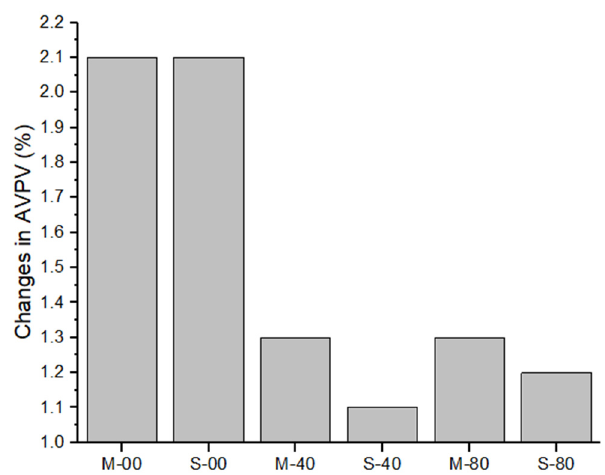
Figure 12. Changes in the AVPV of the concrete specimens.